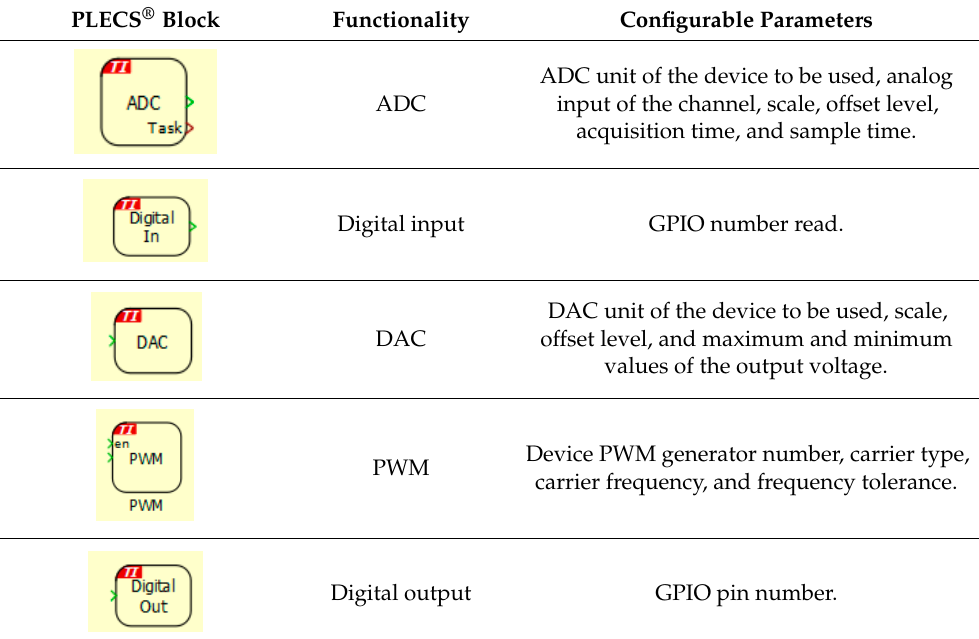
Table 2. Main blocks used in PLECS ® for rapid prototyping of the designed control.